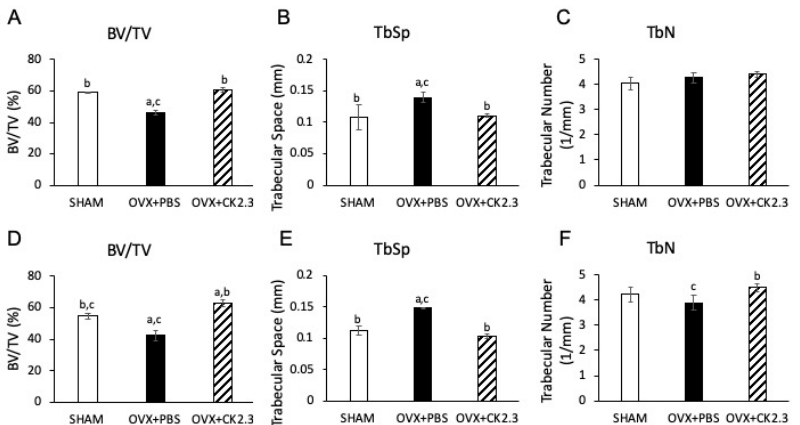
Figure 1. Micro-CT analysis of rat femoral head at week 4 ( A – C ) and week 12 ( D – F ). OVX rats injected Figure 1 . Micro-CT analysis of rat femoral head at week 4 ( A–C ) and week 12 ( D–F ). OVX rats injected with CK2.3 showed improvements in bone architecture. ( A,D ) CK2.3 increased BV/TV ratio; ( B,E) with CK2.3 showed improvements in bone architecture. ( A , D ) CK2.3 increased BV / TV ratio; ( B , E ) CK2.3 decreased TbSp trabecular space; ( C,F ) CK2.3 enhanced TbN trabecular number only at week